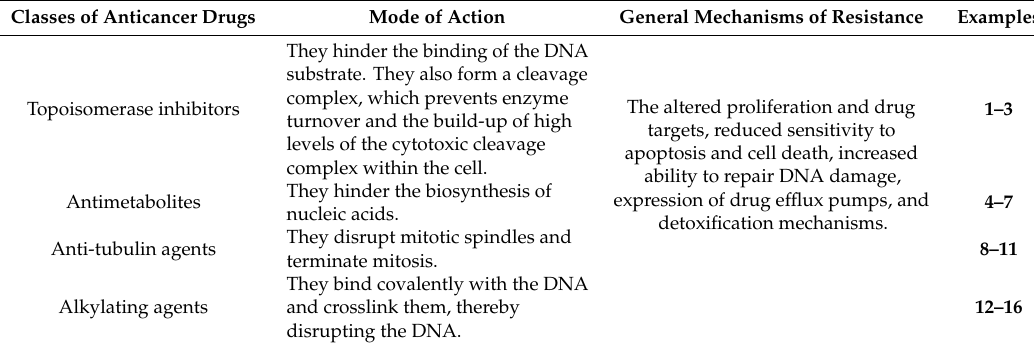
Table 1. A summary of the classification of anticancer